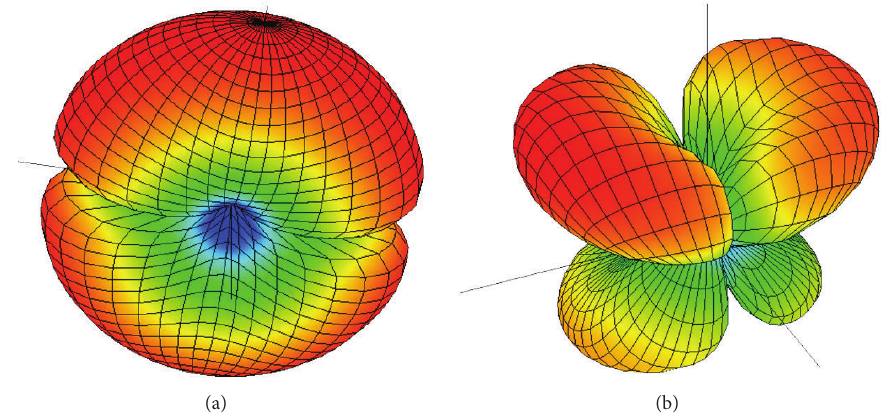
Figure 11: Radiation patterns of the proposed antenna at (a) 780 MHz and (b) 2.350 GHz